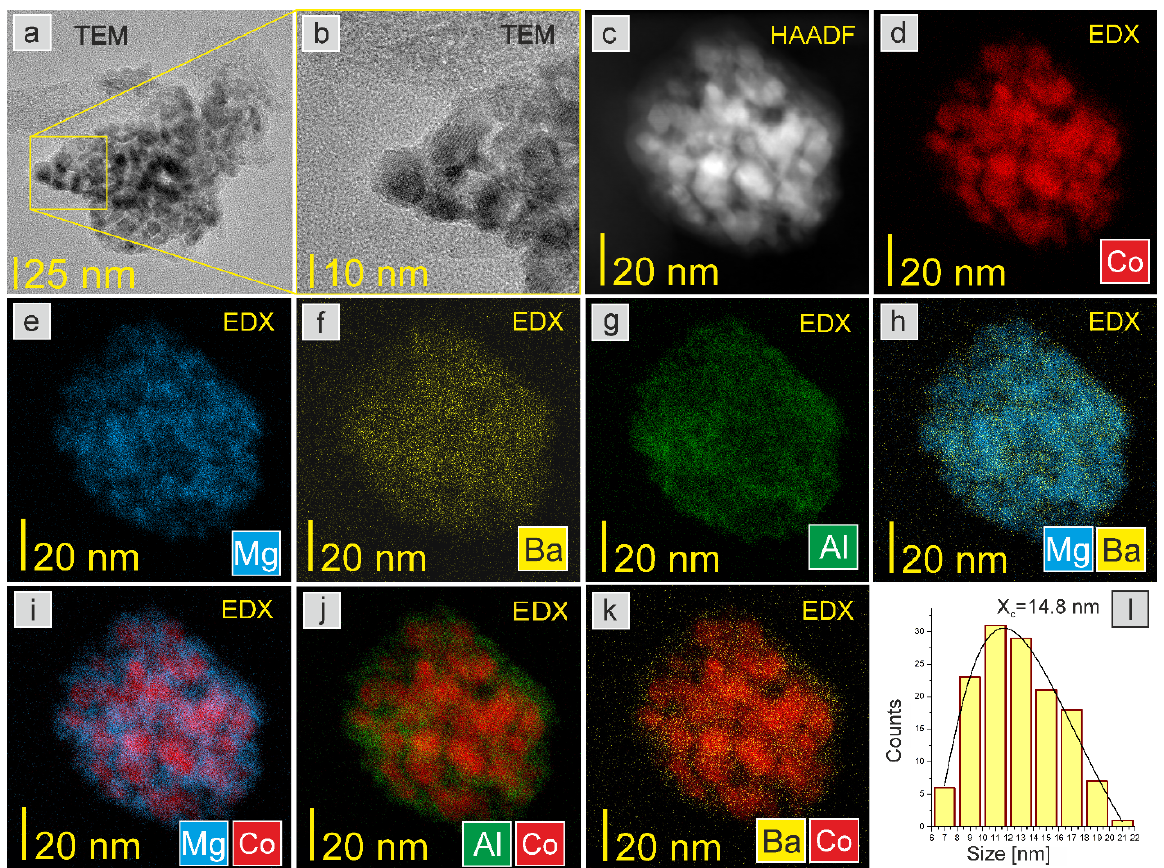
Figure 6. ( a ) TEM image of the Ba/Co/5Mg-Al catalyst with ( b ) an enlarged fragment showing the crystalline structure of the catalyst. ( c ) STEM-HAADF image and corresponding EDX mapping showing a uniform distribution of the elements: ( d ) cobalt, ( e ) magnesium, ( f ) barium, and ( g ) alu- minium. Additionally, EDX maps with two elements are included: ( h ) Mg-Ba, ( i ) Mg-Co, ( j ) Al-Co, and ( k ) Ba-Co. ( l ) Histogram of the cobalt nanoparticles.